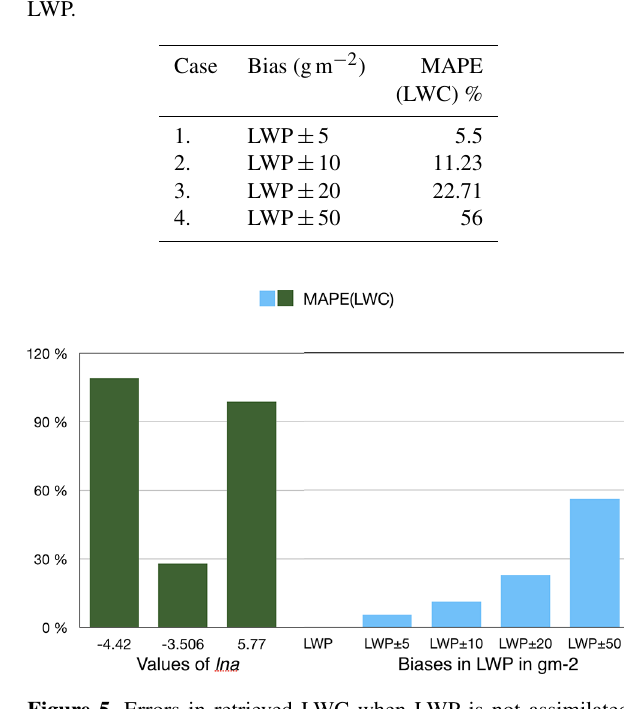
Table 6. Error in retrieved LWC due to bias in Z and LWP.